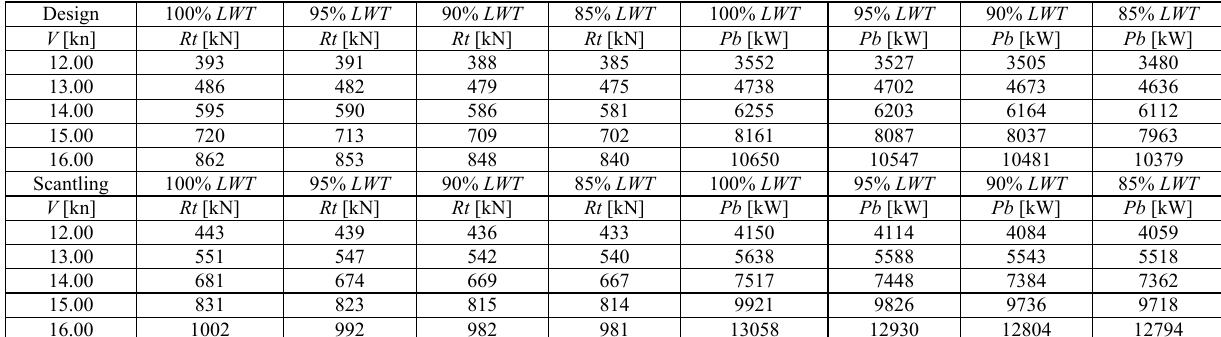
Table 13. Total resistance and brake power – design and scantling draught – bulk carrier 2